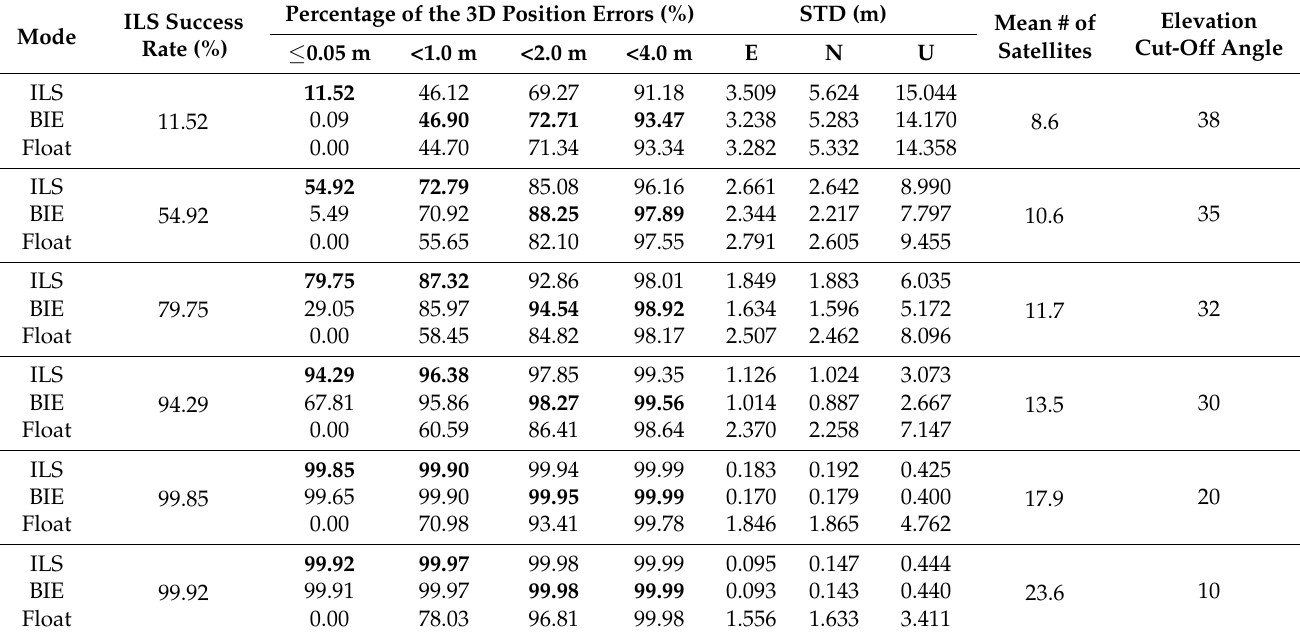
Table 2. Empirical STDs of the ILS, BIE, and float solutions for single-frequency and instantaneous RTK using GP4 smartphones, based on 8 h observations for a short-baseline external antenna data experiment (see Figure 2). Comparisons of the percentage of the 3D position errors within a range of 0.05 m, 1.0 m, 2.0 m, and 4.0 m are also given. Bold values show the largest percentages for each scenario and